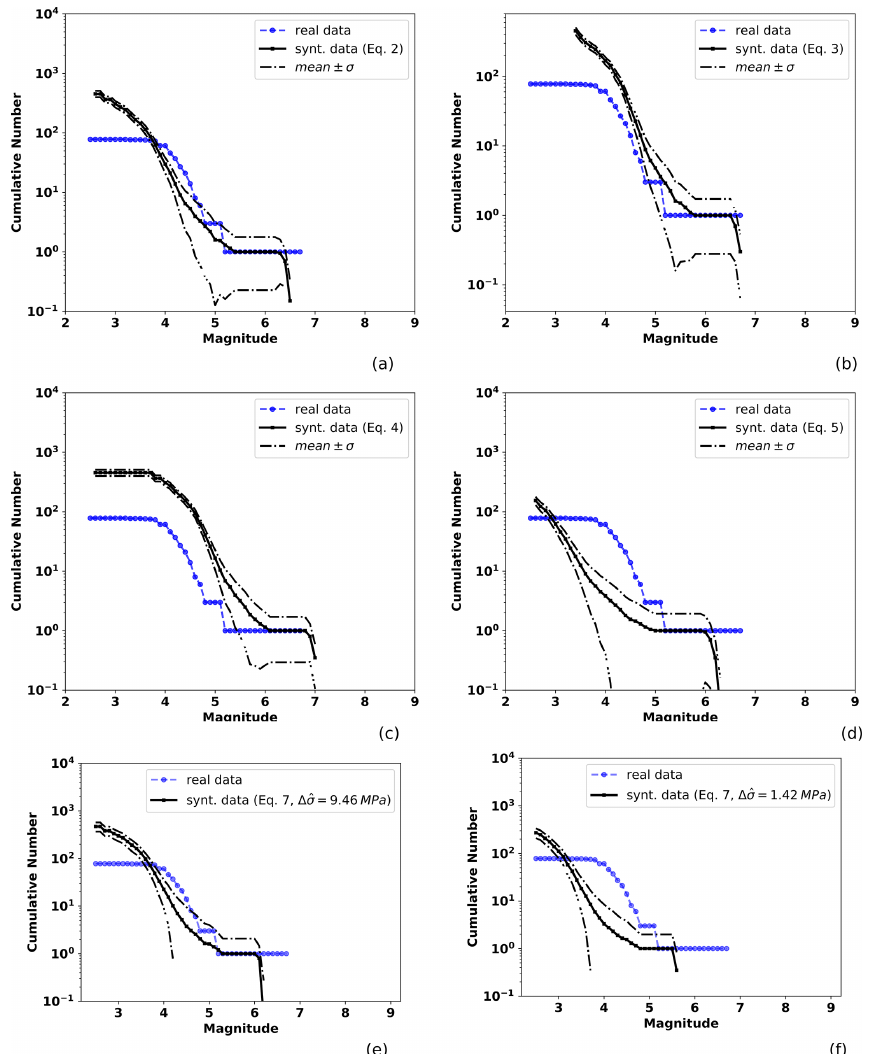
Figure 6. Observed and TREMOL synthetic frequency–magnitude curves for SA region 3 (Table 1). The solid black line indicates the mean after 20 realizations and the broken lines the standard deviation. The blue line is the seismicity curve for events from 1988 to half a year before the mainshock date (19 July 1997), including earthquakes that occurred at the depth range mentioned in the text. Other features as